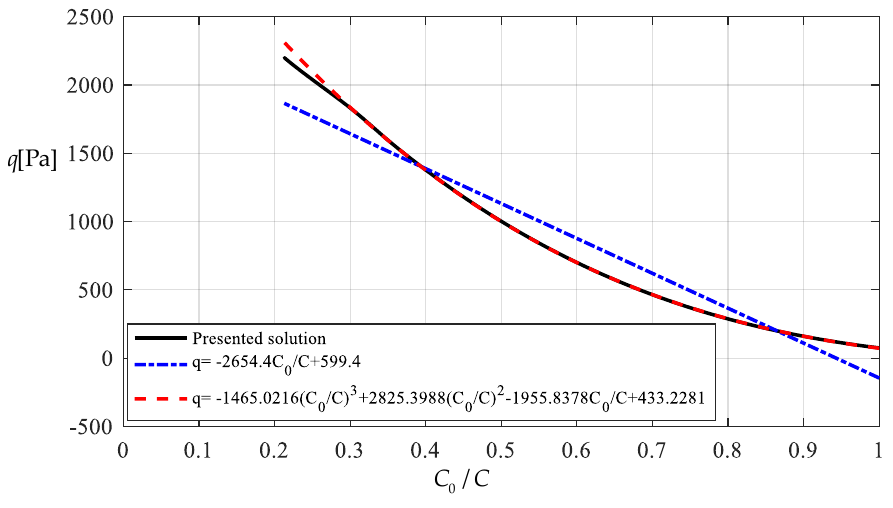
Figure 18. Variations of q with C 0 / C